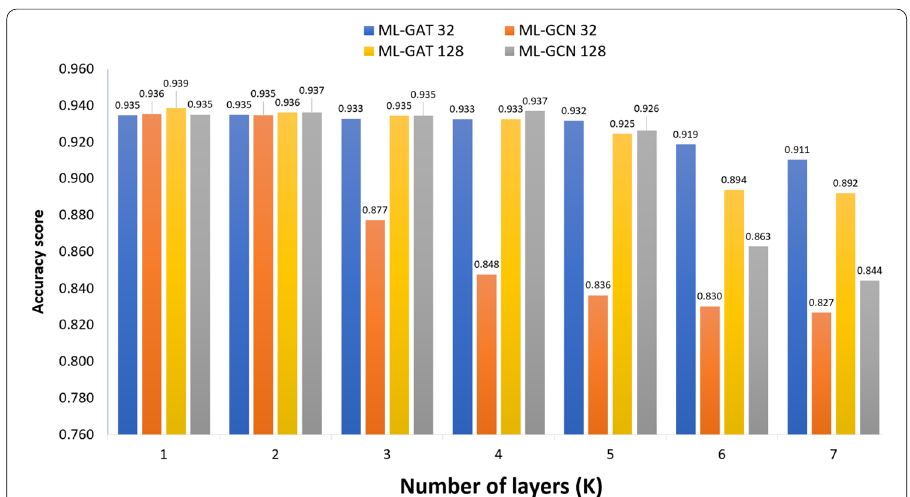
Fig. 8 Accuracy obtained by ML-GAT and ML-GCN, for increasing number of hidden layers K , and with d = { 32,128